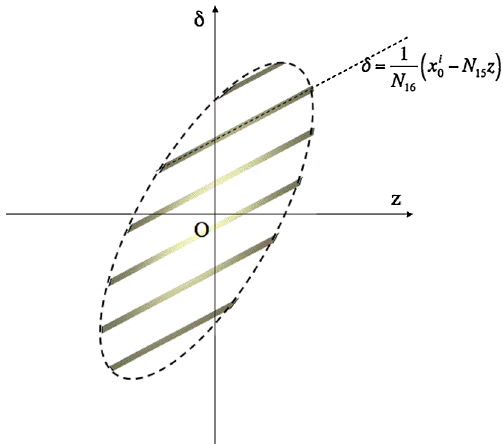
FIG. 2. Rendition of a stratified longitudinal phase space gen- erated downstream of the EEX beam line with an incoming transversely modulated